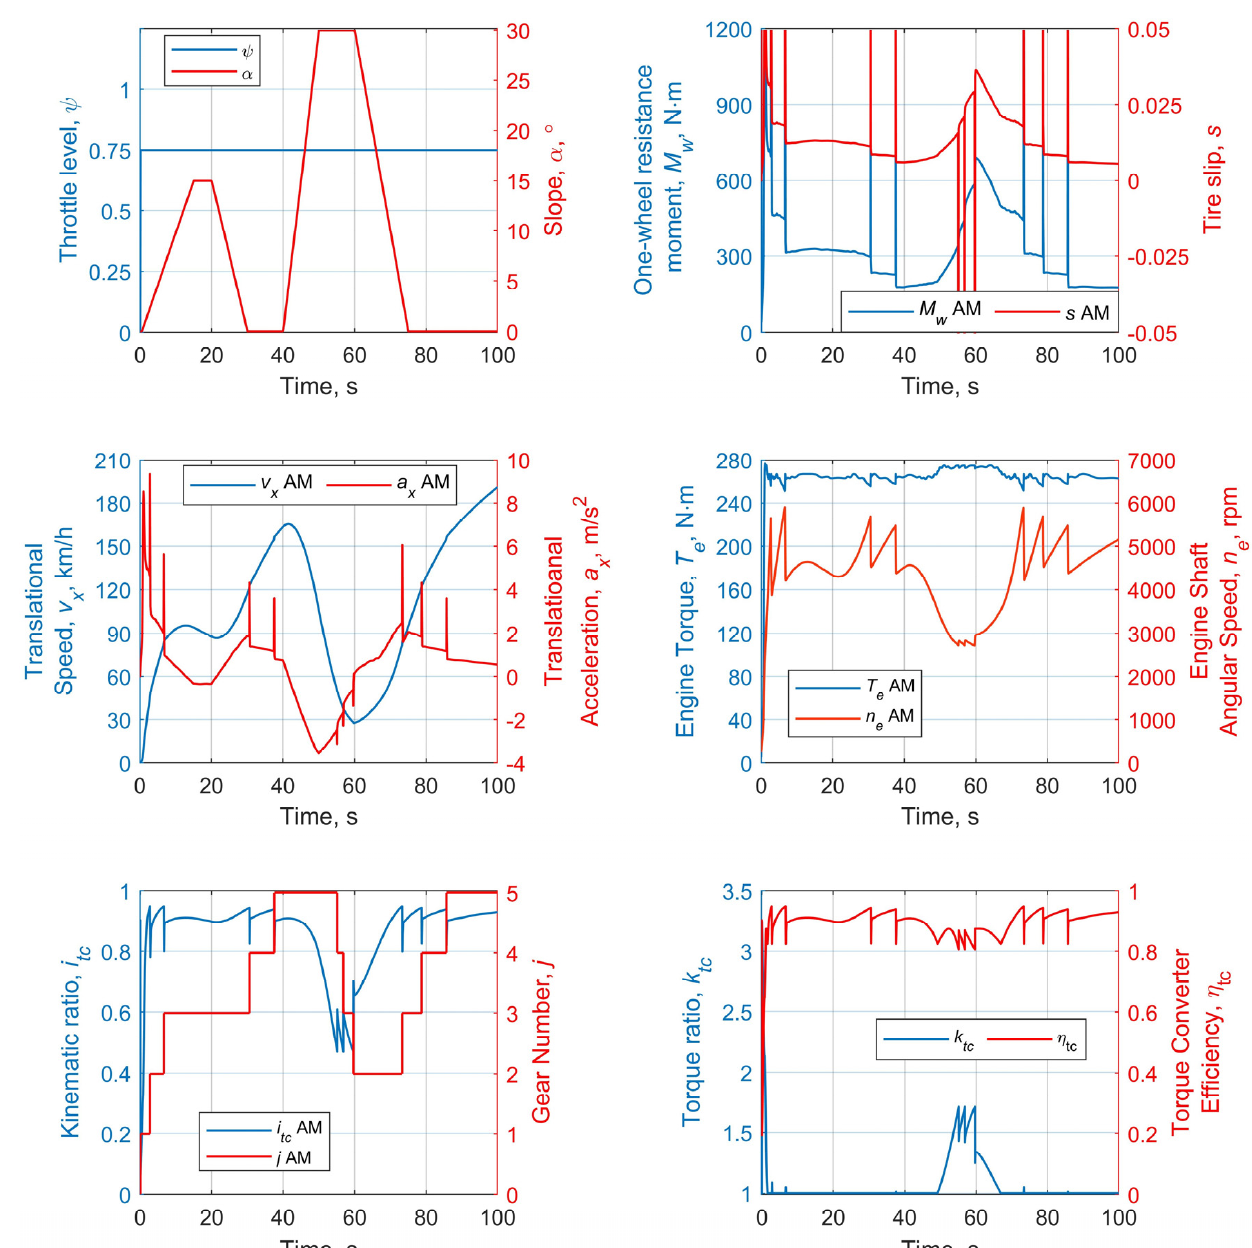
Figure 11. Simulation results for variable slope at accelerator level 0.75.